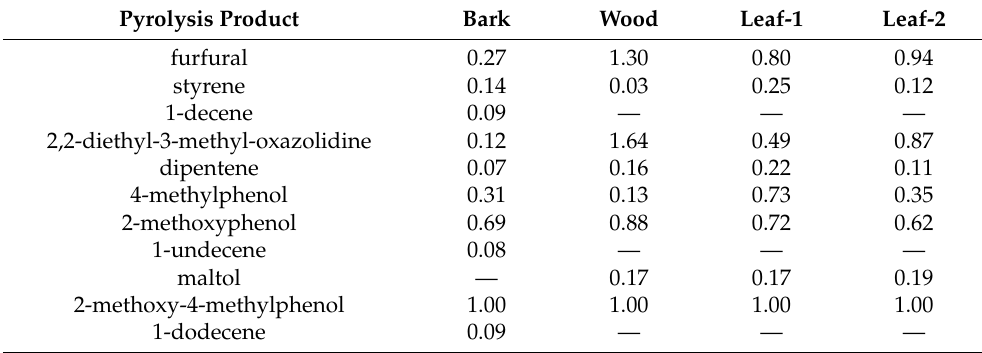
Table 4. Relative intensity ratios (the reference: 2-methoxy-4-methylphenol) of principal pyrolysis products produced from the oak tree